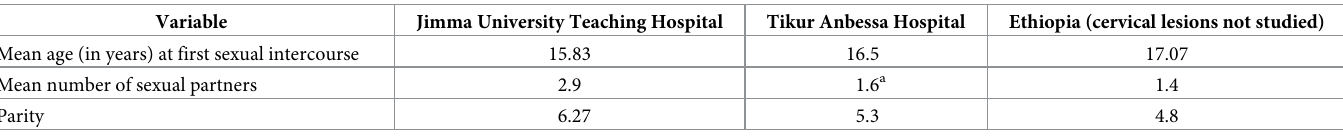
Table 4. Comparison of data pertinent to selected risk factors for cervical cancer from Jimma University Teaching Hospital in southwestern Ethiopia (January 2008—December 2010) and Tikbur Anbessa Hospital in Addis Ababa, Ethiopia (April 2013) [19] from women with a diagnosis of cervical cancer to that of repre- sentative women in Ethiopia (where cervical lesions were not necessarily studied).